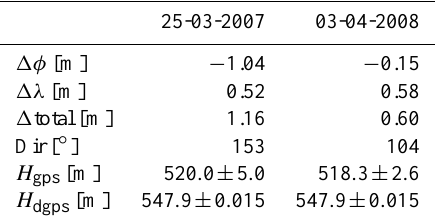
Table 2. Description of the raw and processed data of the reference station NBRef. n is the total number of records in 1 data set, σ r is the combined standard deviation of the raw data, % is the percentage of correct data points, σ is the combined standard deviation of the fil- tered non-averaged data, and σ φ and σ λ are the standard deviations in the latitudinal ( φ ) and longitudinal ( λ ) direction, respectively.